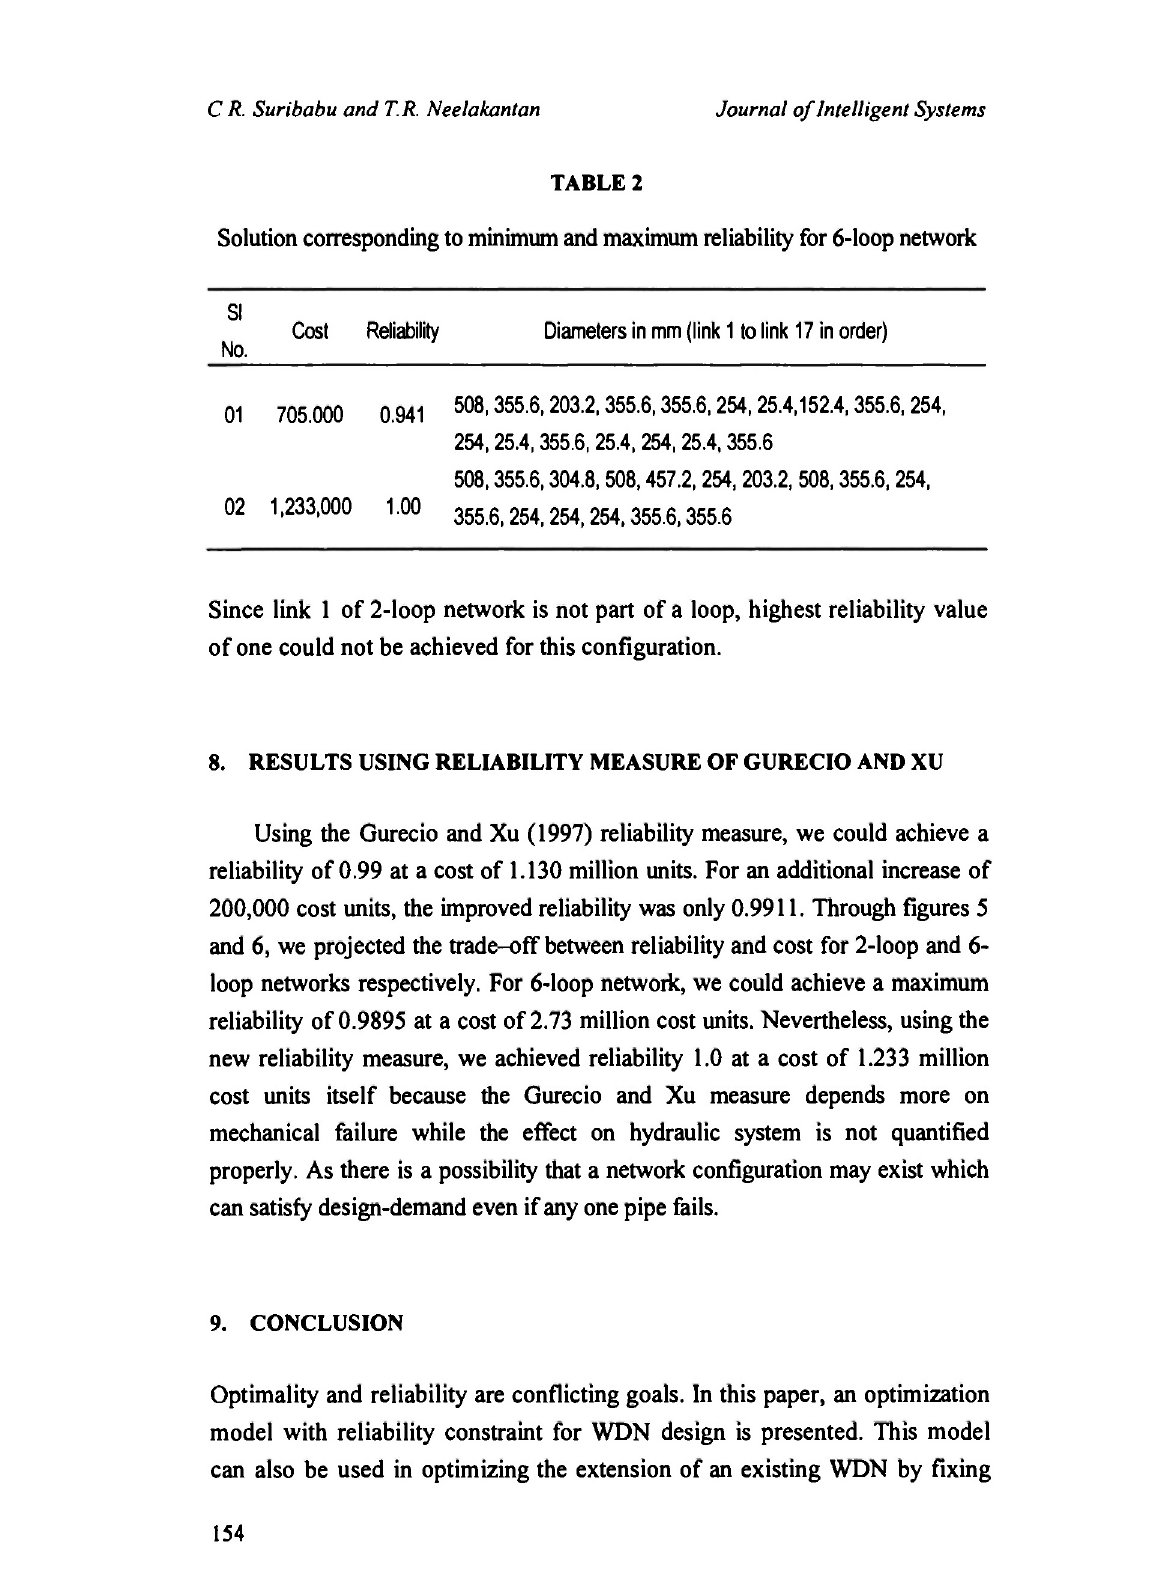
Solution corresponding to minimum and maximum reliability for 6-loop network SI Cost Reliability Diameters in mm (link 1 to link 17 in order)